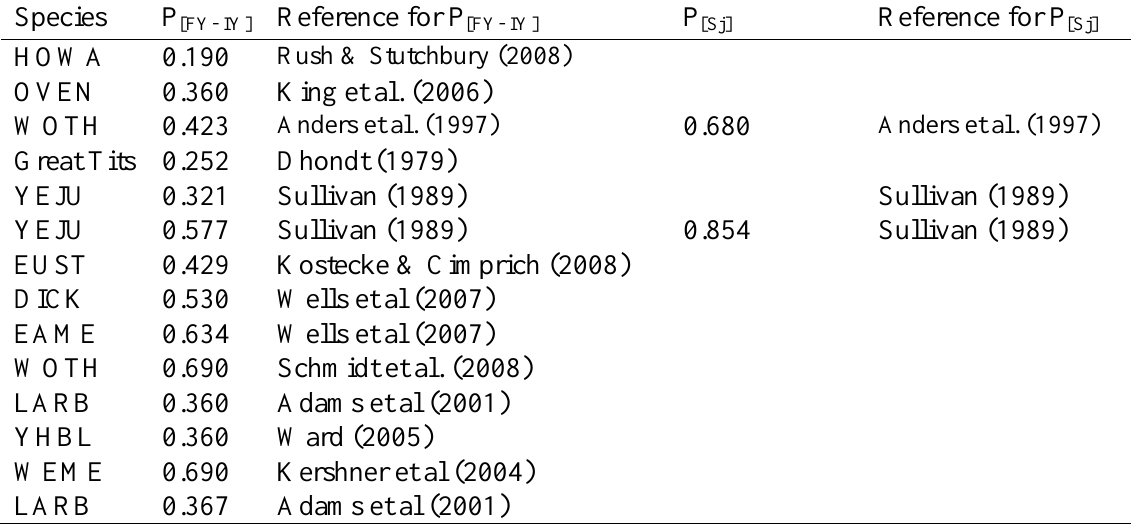
Table A3.2. Literature-derived estimates of the probability of surviving from fledging to independence (P ) and overwinter survival of juveniles (P [FY- IY] to the AOU 2012 (Pyle and De Sante